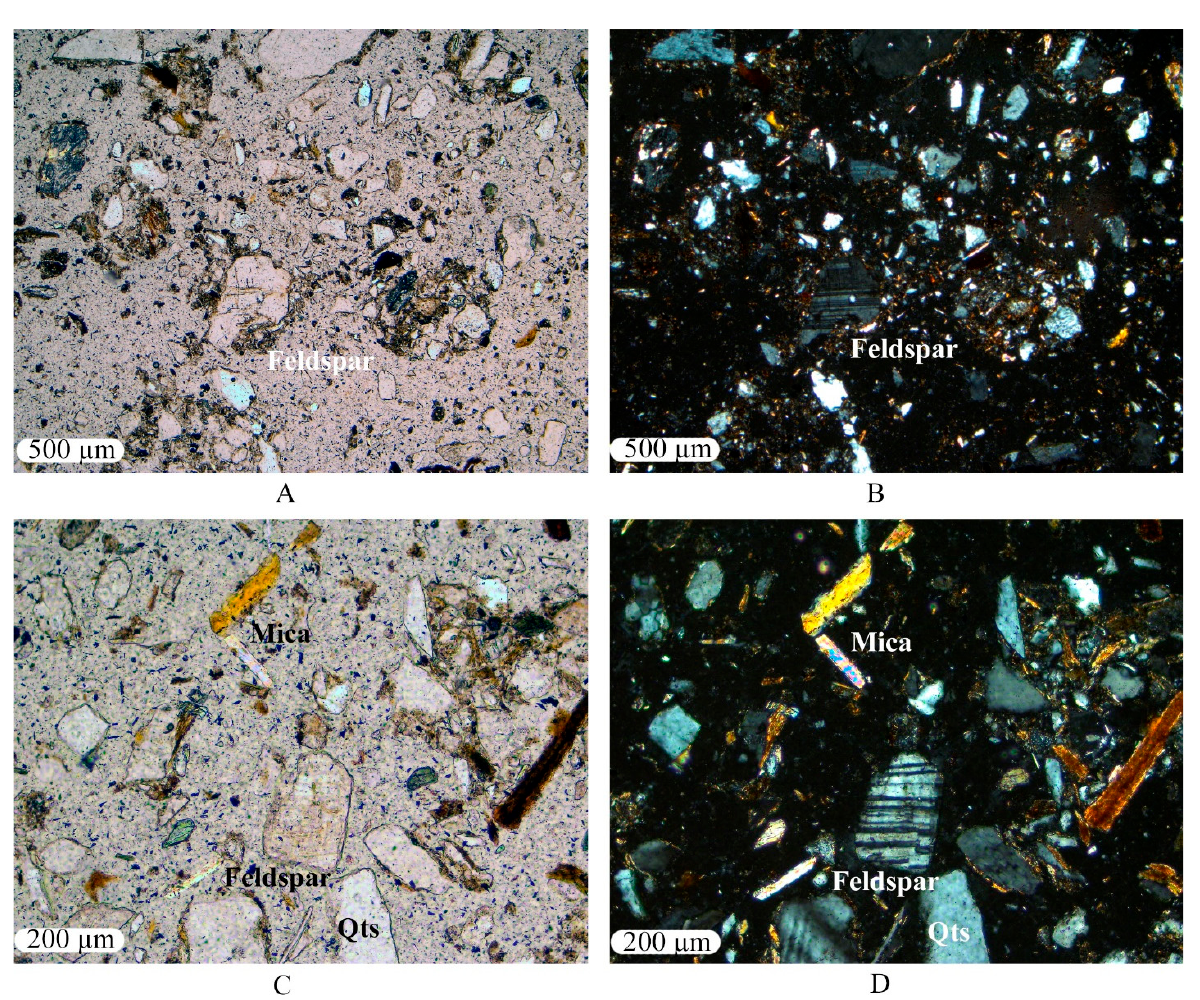
Figure 9. Micromorphological structure of the arable soil Y13 Ahp ( A , B ) and Y13 Bt ( C , D ) soil pro- files. ( A , C ) plane polarized light; ( B , D ) crossed polarized light. ( A , C ) plane polarized light; ( B , D ) crossed polarized